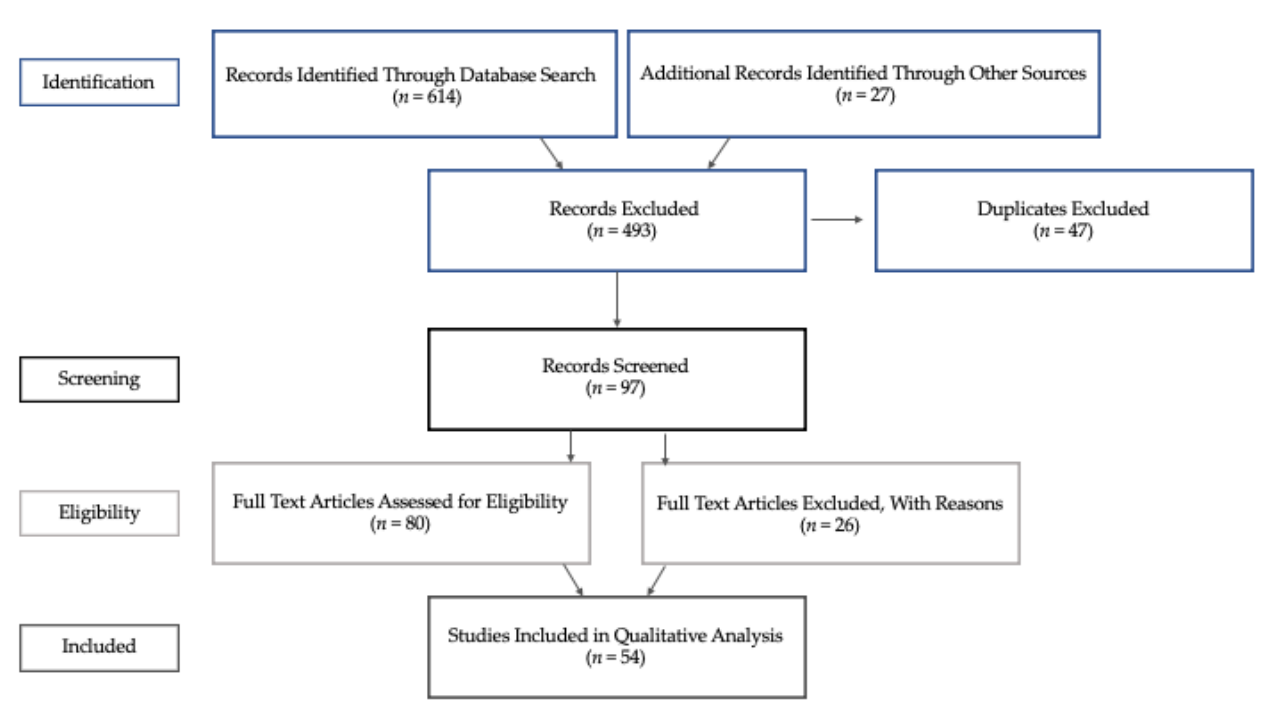
Figure 1. Breakdown of data extraction.